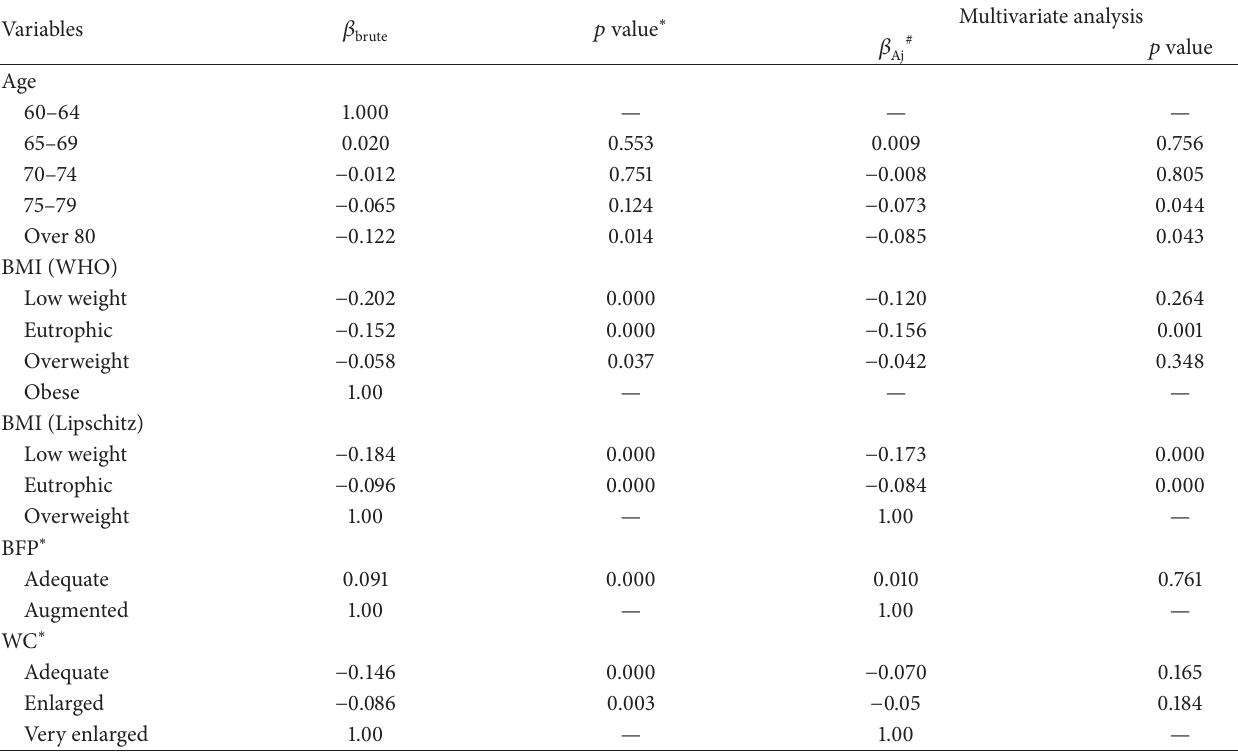
Table 5: Linear regression coefficients (brute and adjusted) for bone mineral density according to sociodemographic, lifestyle, anthropomet- ric, and body composition variables, in elderly women. Goiˆania, GO, 2009. 𝑛 = 132